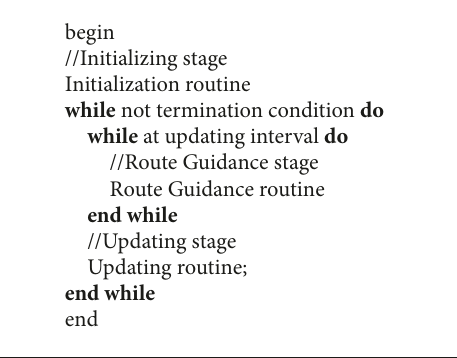
Algorithm 2: Overall procedure of Hierarchical Sarsa Learning based route guidance algorithm.